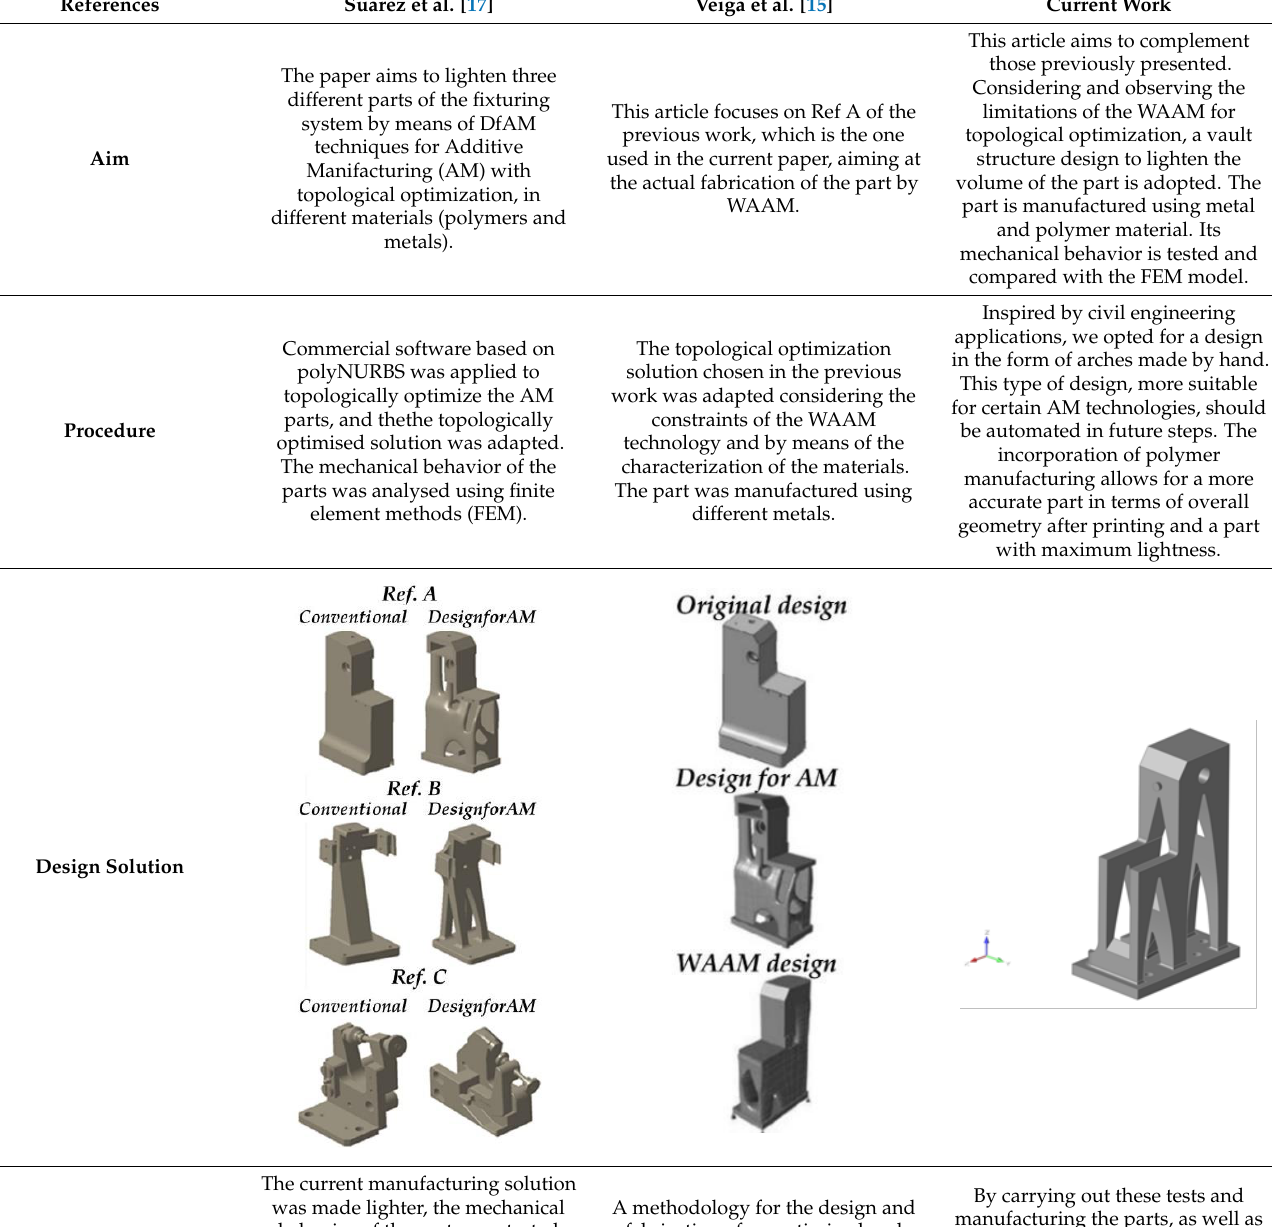
Table 1. Summary of the related work carried out by the research group .